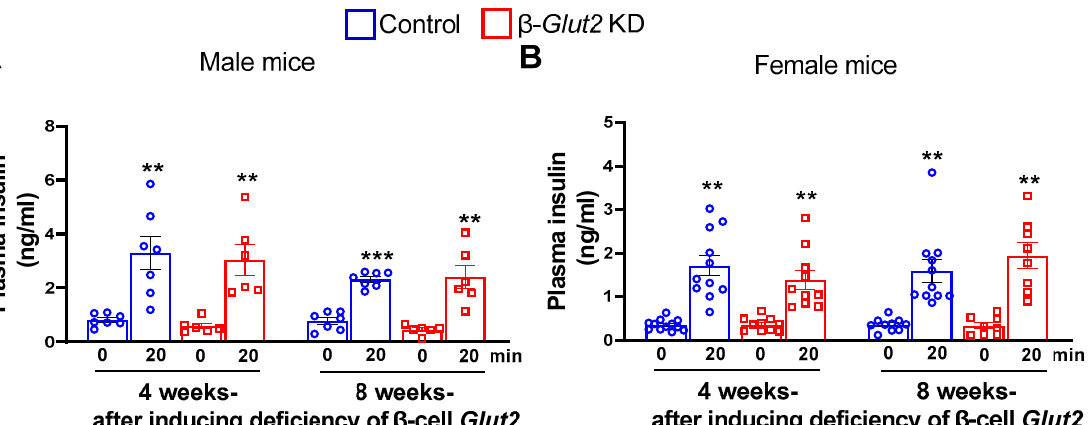
Figure 2. β -cell Glut2 knockdown ( β - Glut2 KD) mice have normal glucose-stimulated insulin secretion. Fasting (6 h) plasma insulin levels (0 min) and glucose-stimulated insulin secretion (20 min) in male, n = 6 or 7 ( A ) and female, n = 8, 10, or 11 ( B ) mice 4 and 8 weeks after inducing β -cell Glut2 deficiency. The mice were 8–10 weeks old when β -cell Glut2 deficiency was induced. Repeated measures two-way ANOVA followed by Bonferroni’s multiple comparison test were used for comparisons. ** p < 0.01, *** p < 0.001 vs. their corresponding baseline (0 min) groups. Error bars are mean ± SEM.